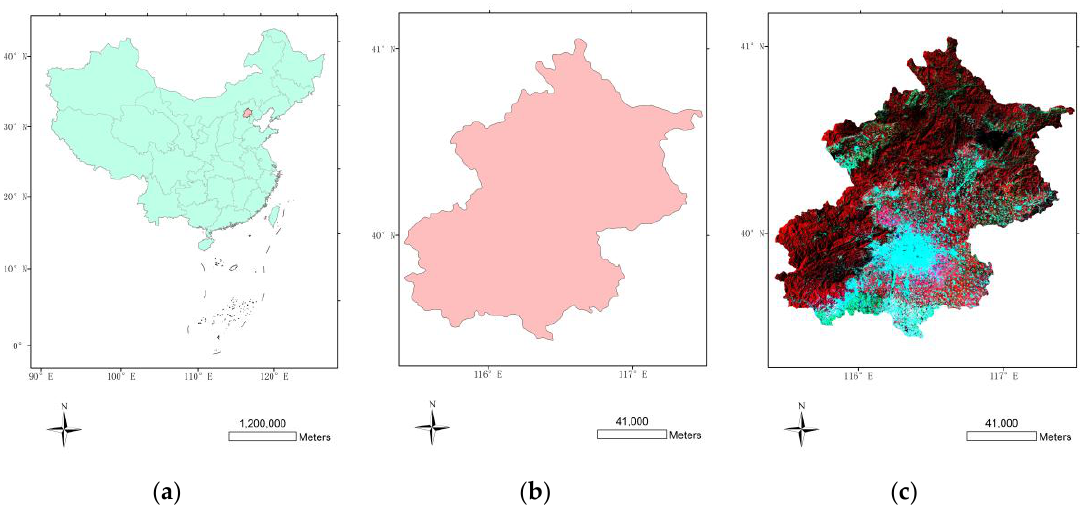
Figure 1. Maps showing administrative areas and terrain. ( a ) The geographical location of Beijing, China; ( b ) Political map of Beijing; and, ( c ) Topographic map of Beijing derived from Landsat 5 data.